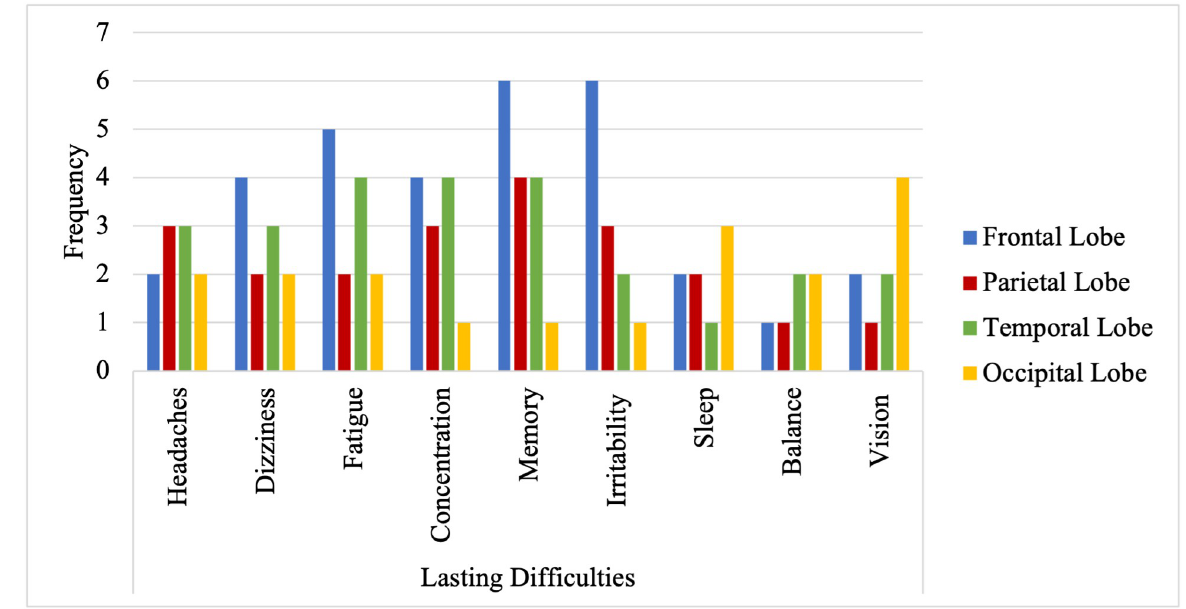
Fig 1. Frequency of self–reported lasting difficulties according to self-reported location of